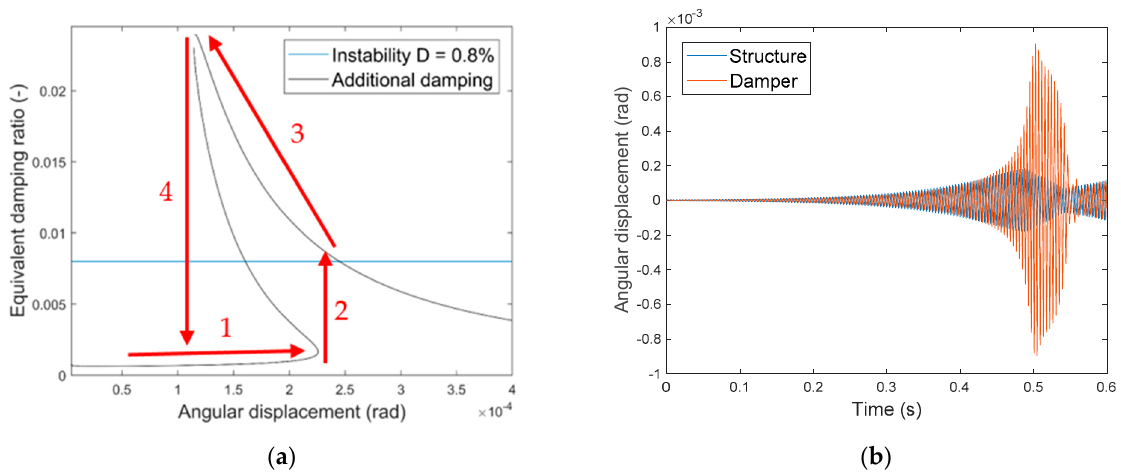
,(cid:2033) (cid:2868) = 1000 (cid:2869) , Ω = 1500 (cid:2869) , (cid:1836) = 0.2 (cid:1863)(cid:1859)(cid:1865) (cid:2870) ) (cid:3046) (cid:3046) (cid:3046) , ω 0 = 1000 1 , Ω = 1500 1 , J = 0.2 kgm 2 ) s s s